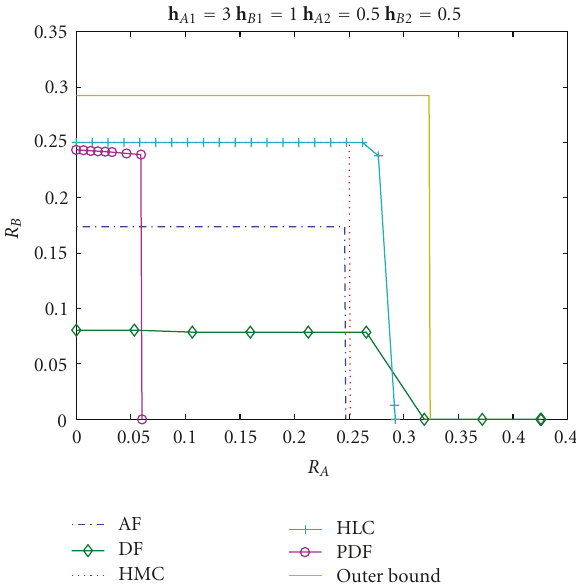
Figure 5: The achievable rate regions when one relay has large link gains (symmetric case).